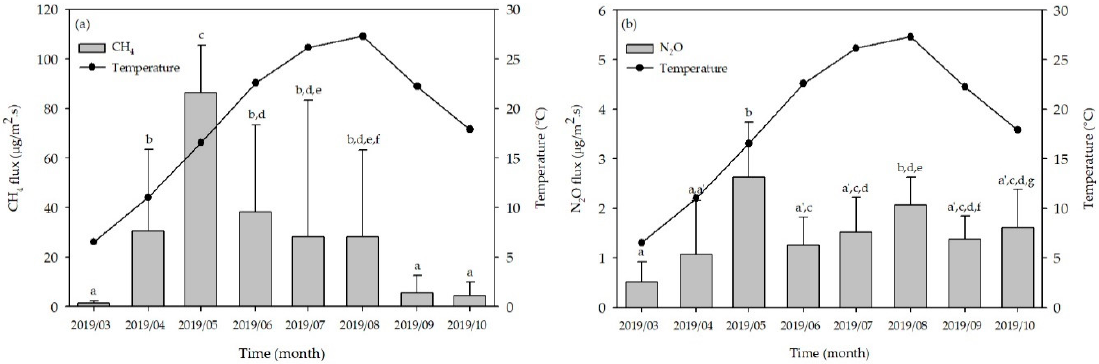
Figure 9. Monthly average emissions of ( a ) CH 4 and ( b ) N 2 O from composting lot. Flux means with the same letter are not significantly different ( p > 0.05).